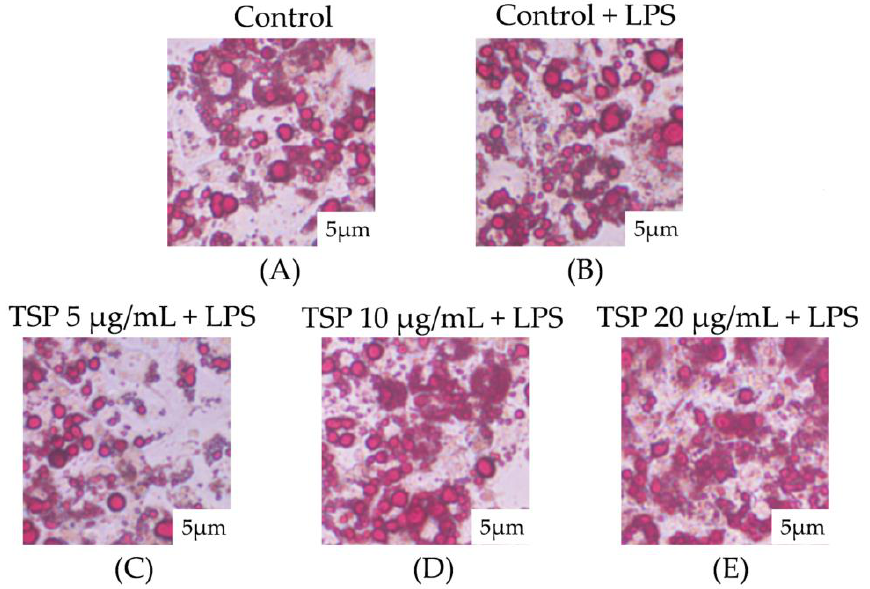
Figure 2. Oil red O staining of the effect of TSP on inflammatory-induced lipid accumulation in adipocytes: ( A ) is a blank control group; ( B ) is a positive control group under inflammatory conditions; ( C ) is TSP concentration 5 µg/mL low dose group; ( D ) is TSP concentration 10 µg/mL Medium dose group; ( E ) is TSP concentration 20 µg/mL high dose group.